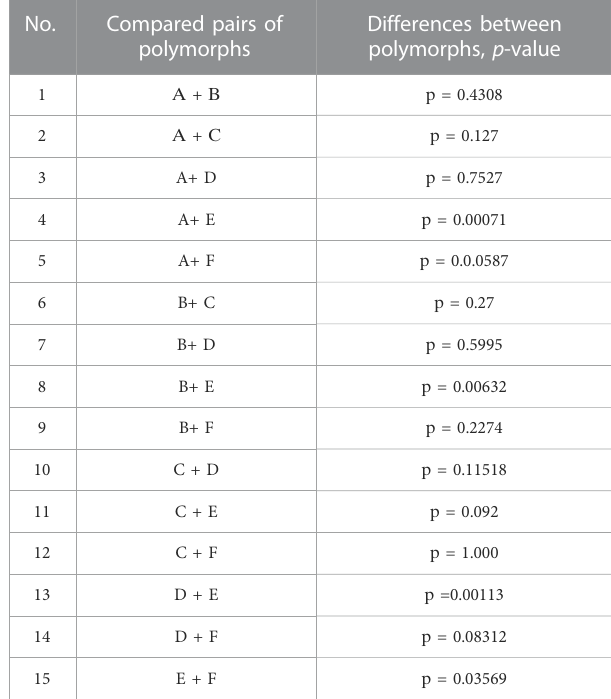
DataarepresentedasMeanvalueinseconds±SEM.,Doseforallpolymorphswas10 mg/kg.Differenceswereconsideredstatisticallysigni fi cantatp < 0.05(Mann-WhitneyU-test),highlighted in bold.